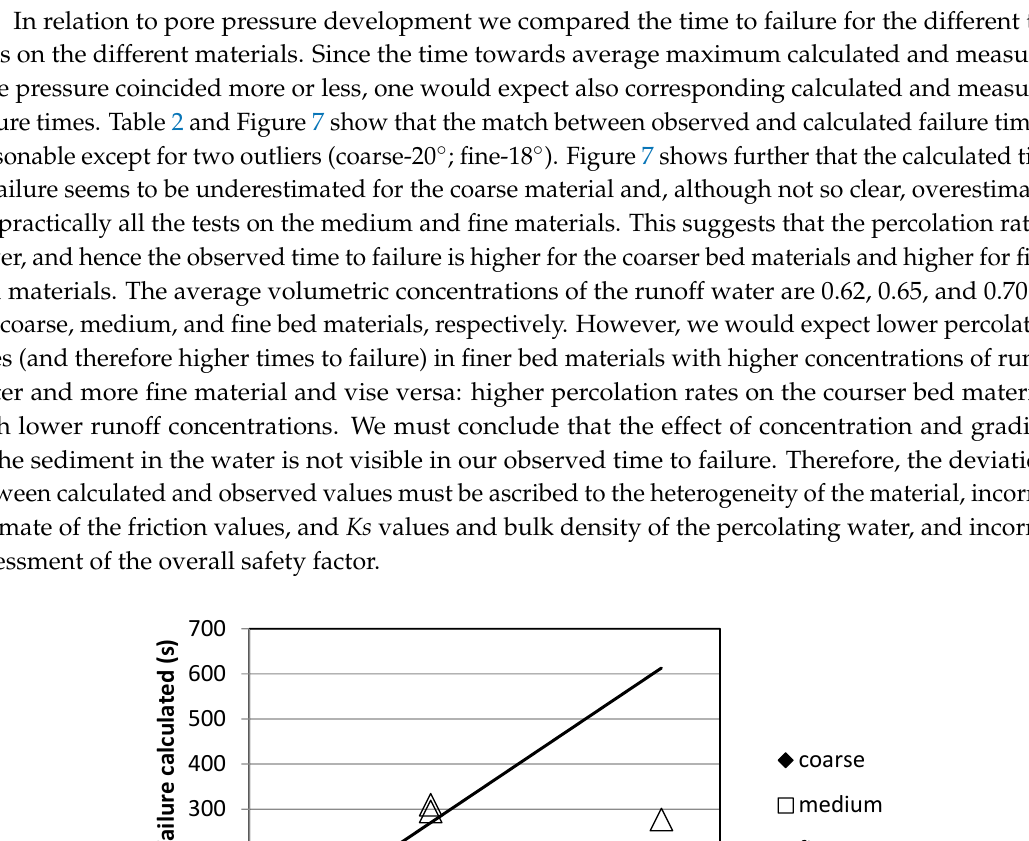
Figure 6. Example of the rise in pore pressure (measured/calculated) due to infiltration of run-on water in the bed material (test: medium grain size/20°).